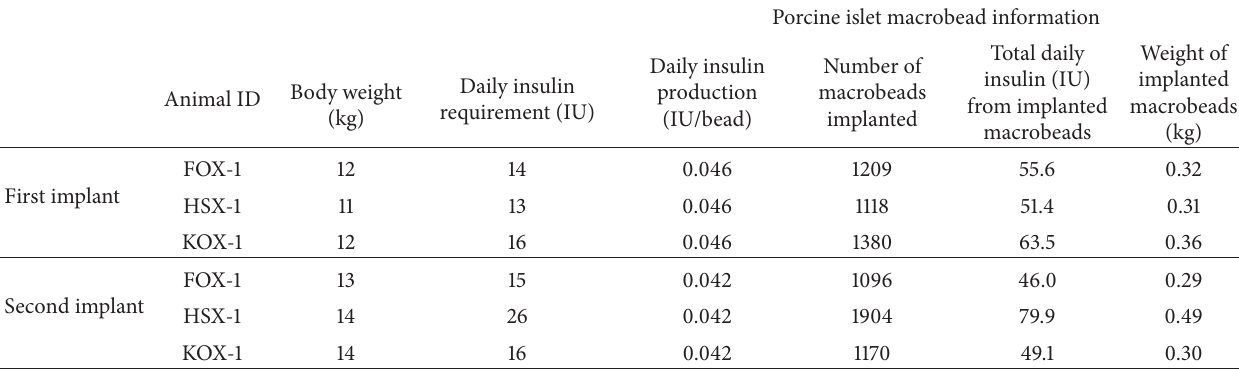
Table 3: Individual dog insulin requirements and islet macrobead information at first and second